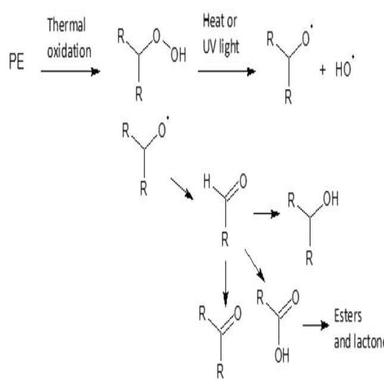
Common products in the thermal- and photo-oxidative degradation processes for polyethylene. Please note that "R" represents a polymer chain of variable length.